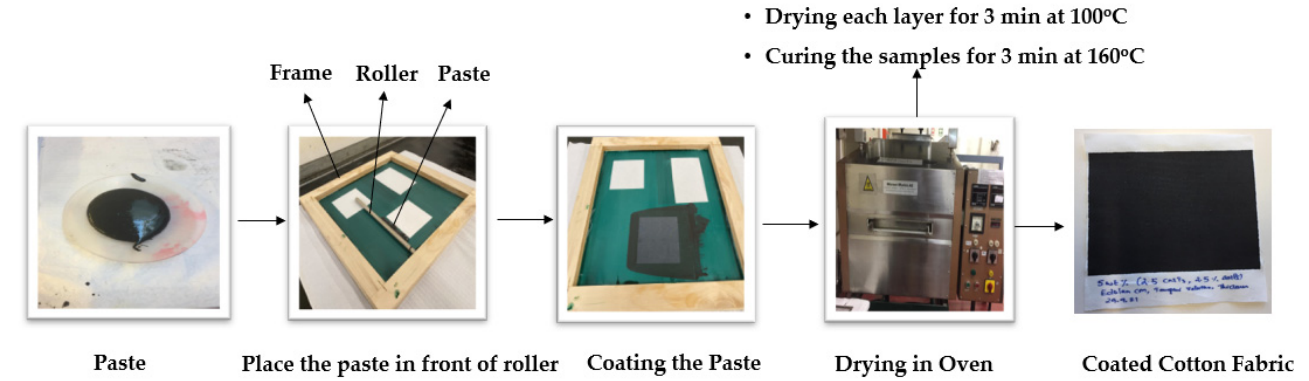
Figure 2. Steps involved in the screen-printing process.